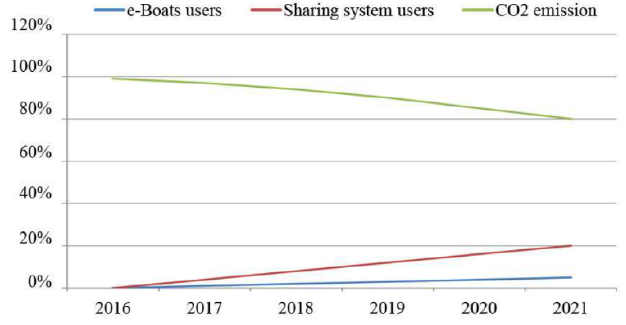
Figure 2. Expected results in terms of CO 2 reductions.